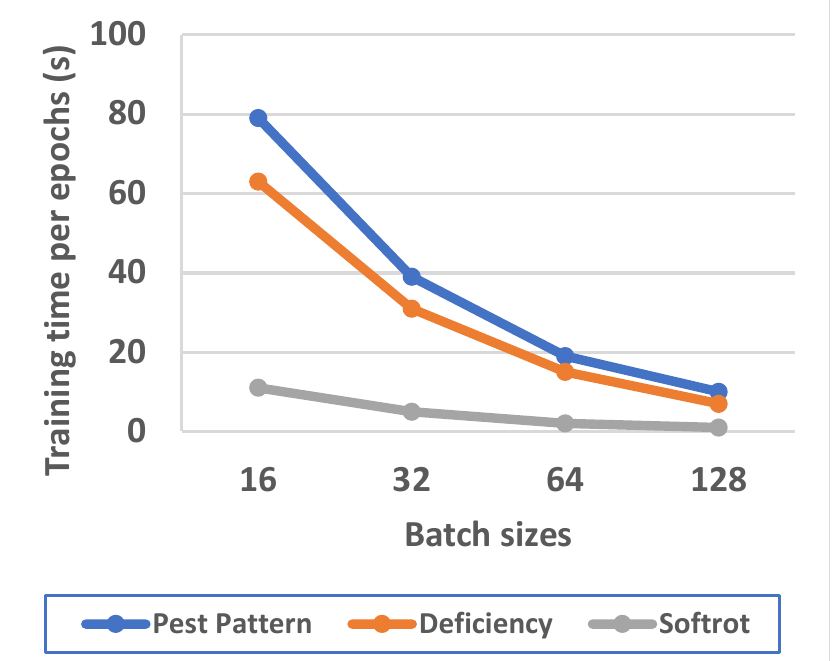
Figure 11. Computational cost on different